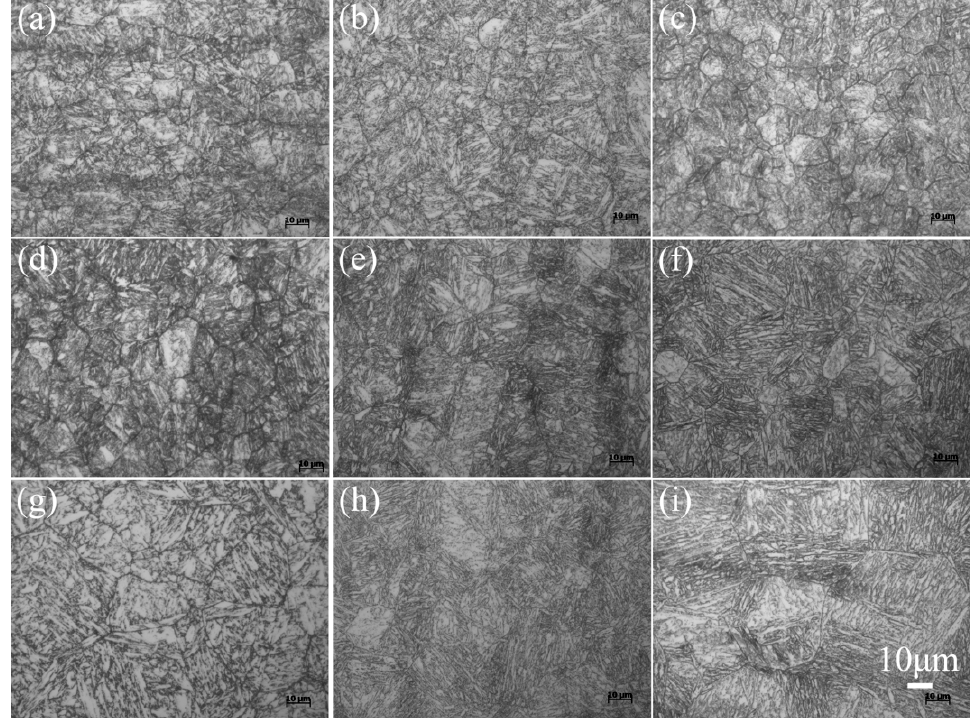
Figure 1. Optical micrographs of 15Cr12MoVWN steel under different heat treatment conditions. ( a ) 0W, ( b ) 0O, ( c ) 0A, ( d ) 5O, ( e ) 5A, ( f ) 5W, ( g ) 8A, ( h ) 8W, ( j ) 8O.